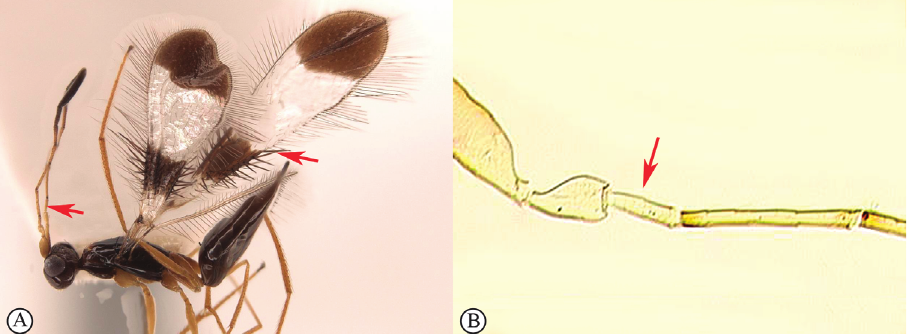
3 Longest modified wing spine marginally longer than wing width at point of spine attachment (A); mesosoma dark brown (A); first flagellar antennal seg- ment equivalent to pedicel length (A, B) ................... P. dikobraz